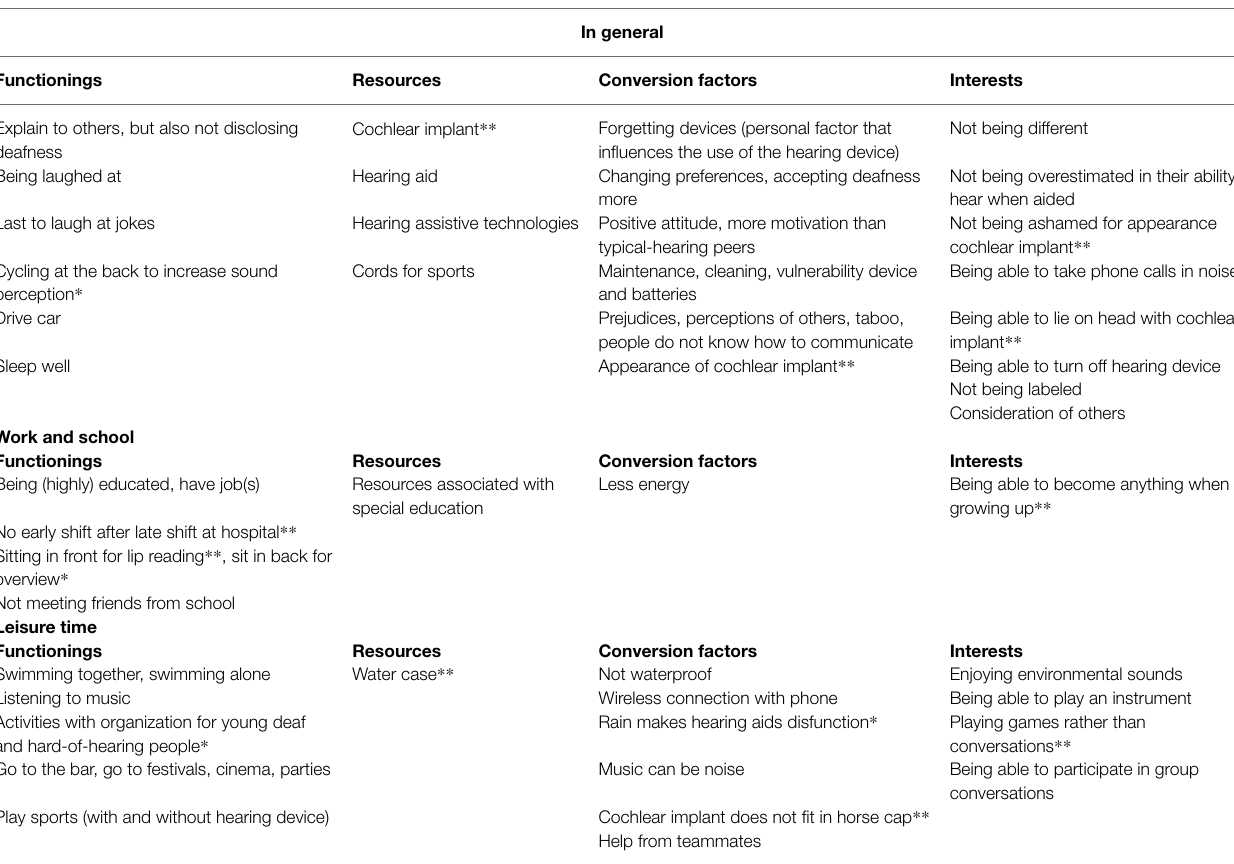
TABLE 2 | Participants’ input in terms of capability